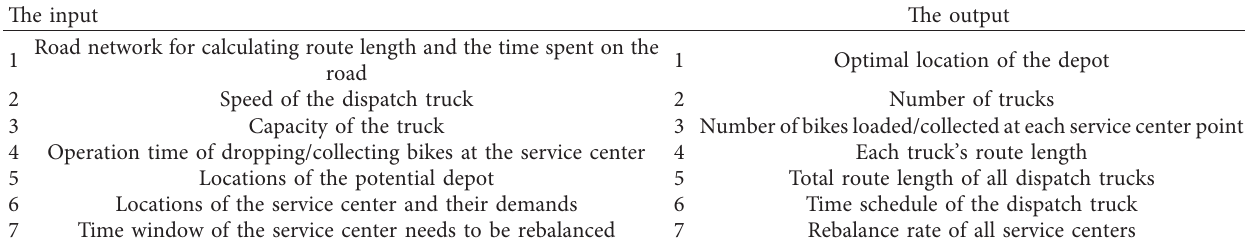
Table 1: The input variables and output variables of the VRP model.